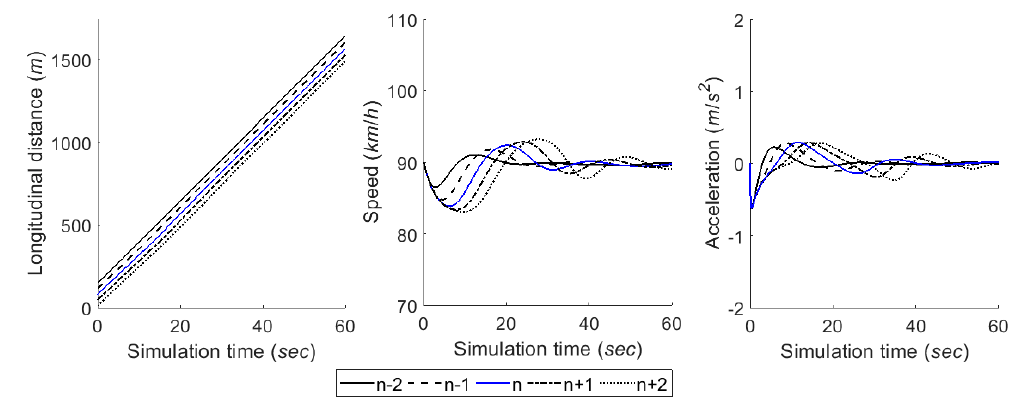
Figure 13. Performance of the car-following module.